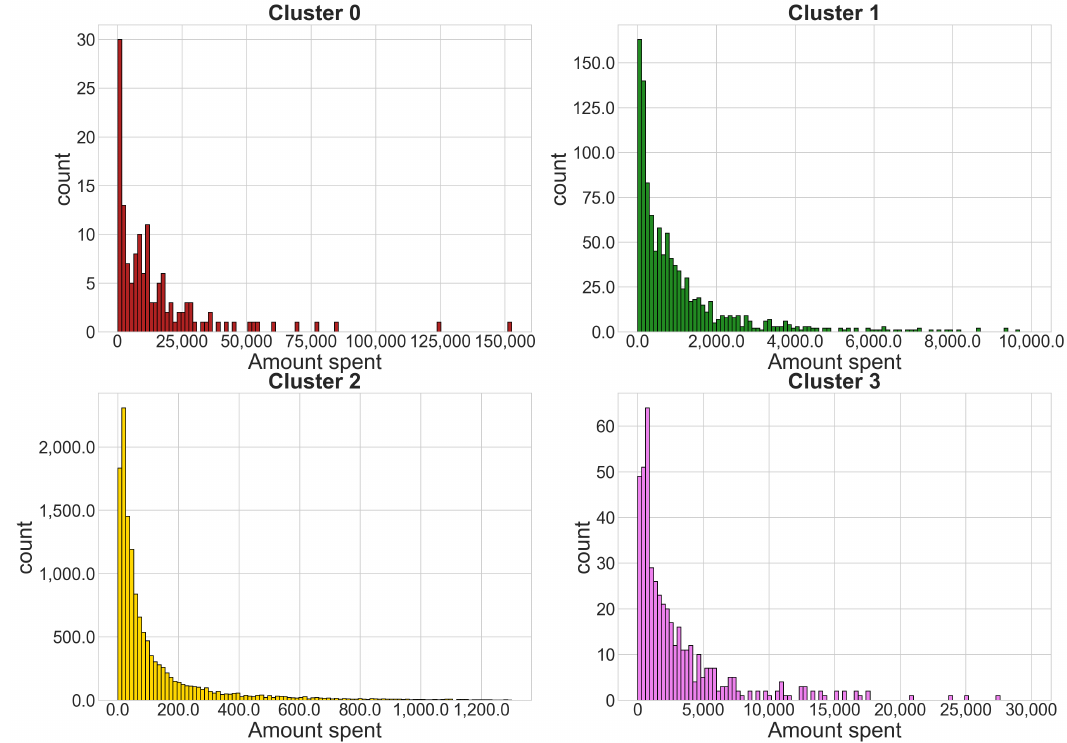
Figure 4. Histograms of the total amount spent obtained using the time series k -means algorithm. The x axis reports the amount spent, while the y axis shows the number of players that spent that amount during the